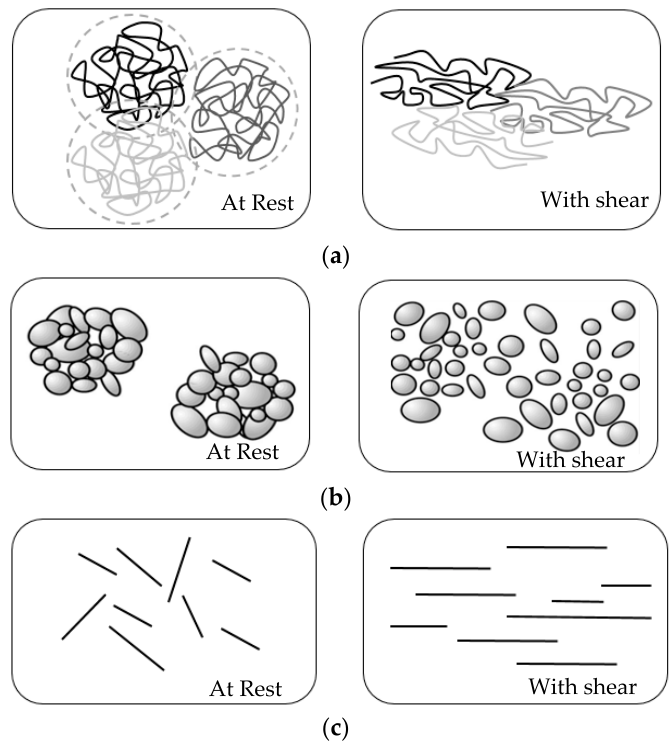
Figure 4. Schematic representation of shear-thinning mechanisms ( a ) polymer solutions/melts; ( b ) suspensions; ( c ) dispersions, adapted from [6].